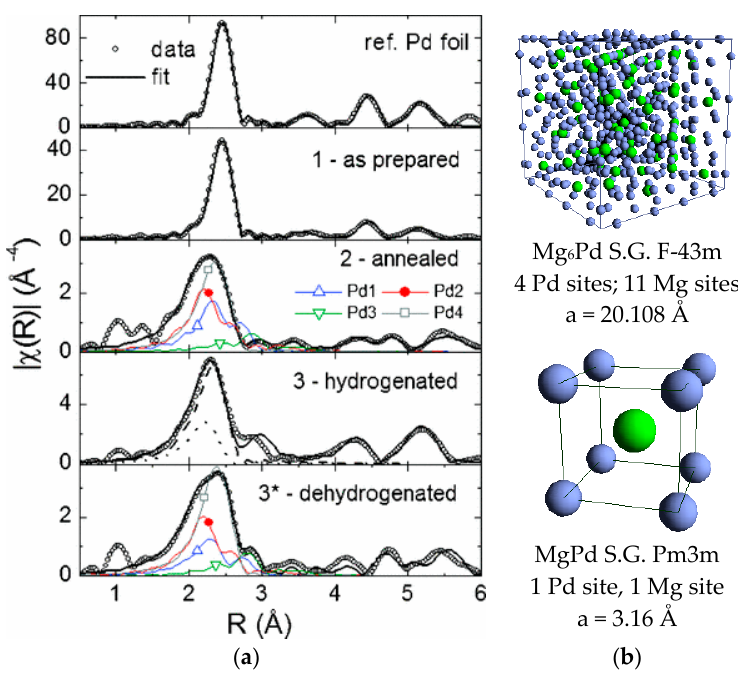
Figure 11. Local structure around Pd in Mg-Pd NPs. ( a ) Magnitude of the Fourier Transform of raw Extended X-ray Absorption Fine Structure (EXAFS) spectra at the Pd K-edge (open circles) and corresponding fit (thick solid lines). In the graphs of sample 2 and 3*, the first-shell-like contributions from the four different Pd sites in the Mg 6 Pd structure are displayed as thin solid lines marked by one symbol. Adapted with permission from Ref. [71]. Copyright 2011 American Physical Society. ( b ) Crystal structures of the intermetallic compounds Mg 6 Pd and MgPd.